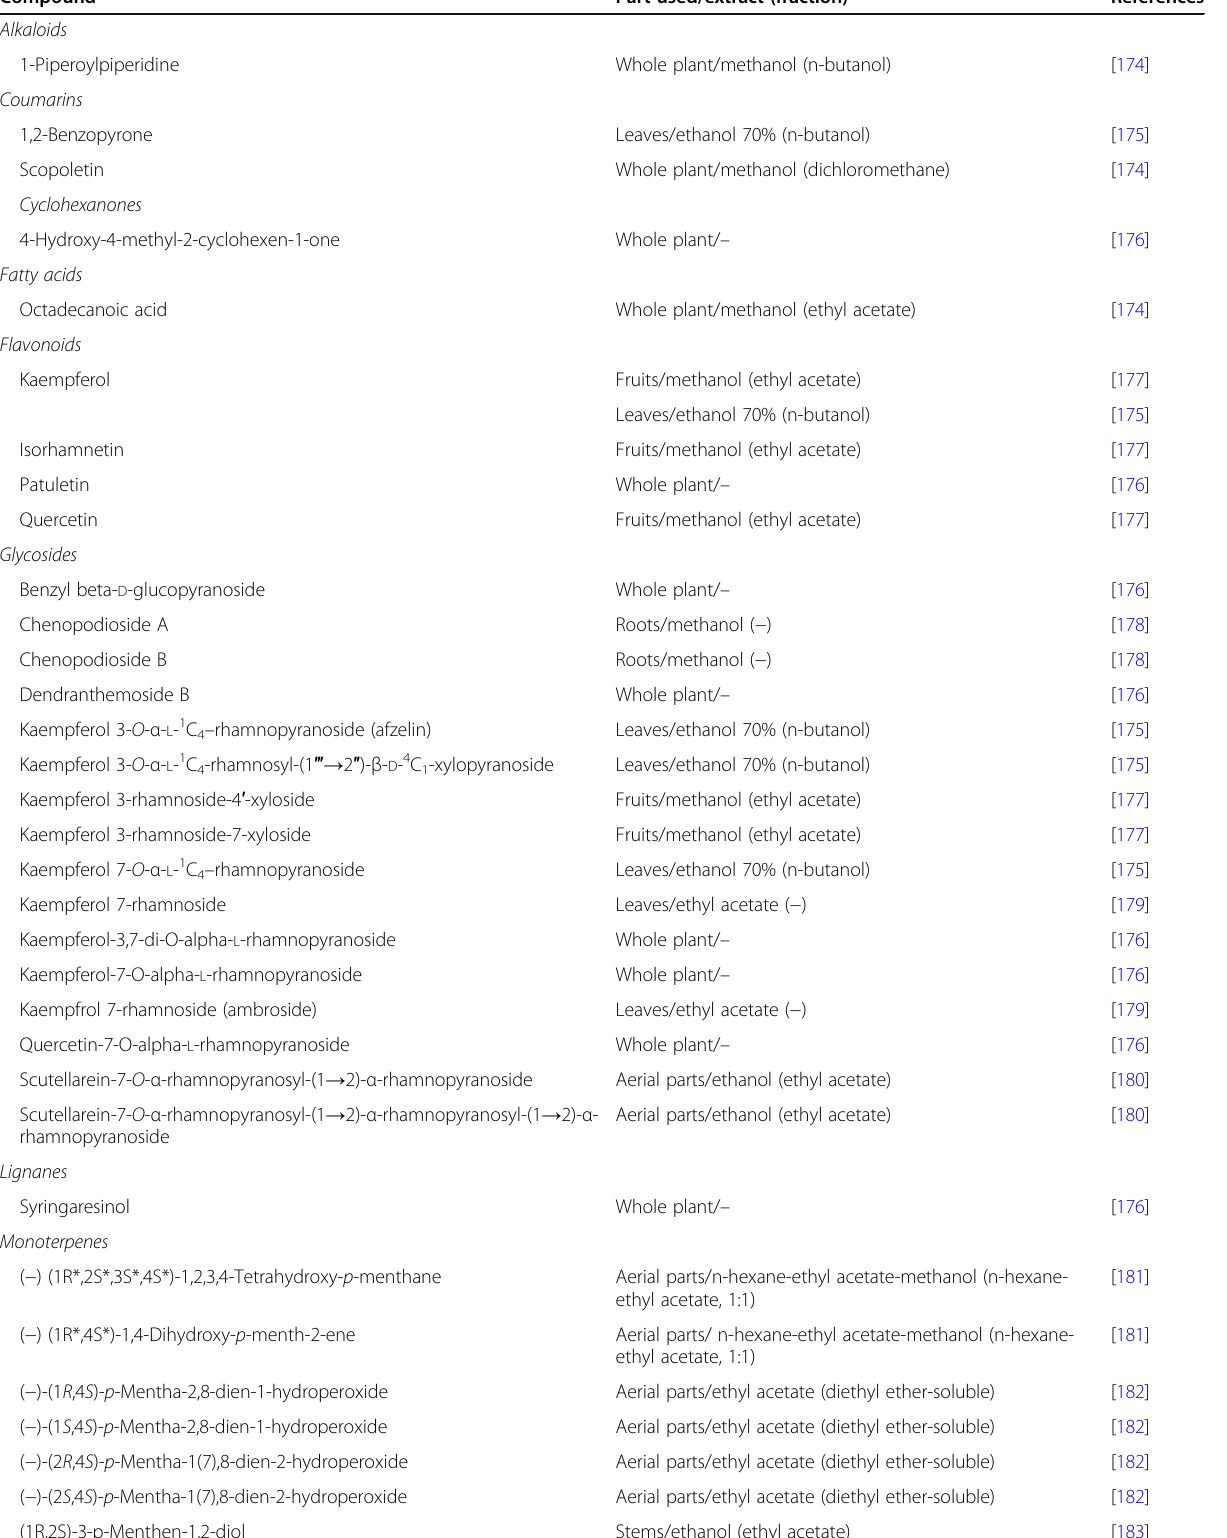
Table 2 Secondary metabolites isolated from C.